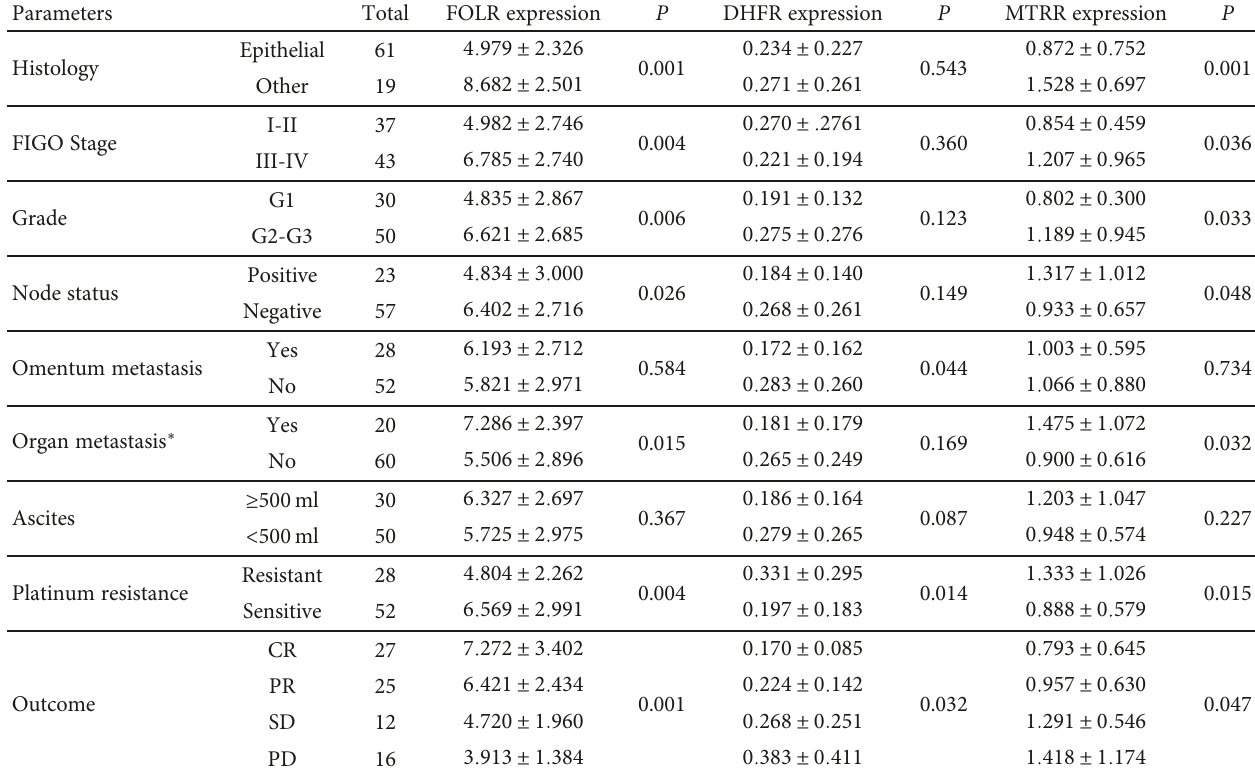
Table 2: Correlation between FOLR1, DHFR, and MTRR expression and clinicopathological parameters.